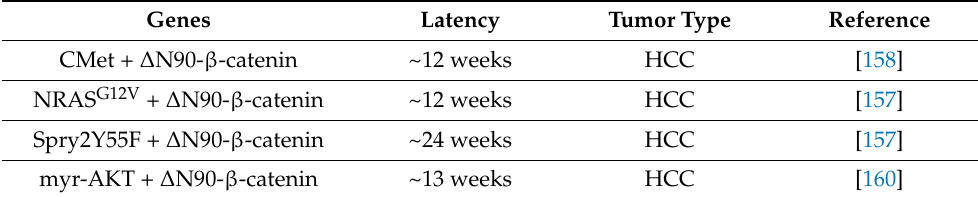
Table 2. Development of HCC in murine models expressing destruction-resistant β -catenin and its oncogenic